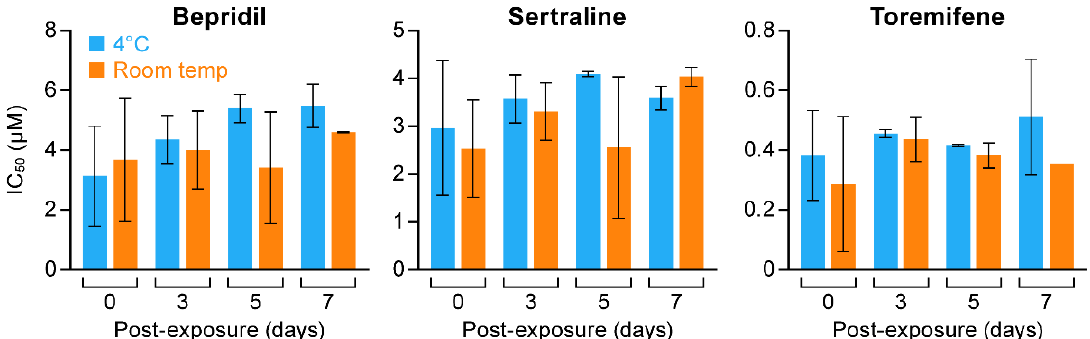
Figure 3. Activity of bepridil, sertraline and toremifene in V8 against EBOV/Mak over seven days. Drug stocks were prepared on d0 in V8 as for Figure 2, stored at 4 °C (blue bars) or RT (orange bars), and then tested in 8 point dose reScheme 0. d5, and d7 using 2-fold serial dilutions in V8. Huh7 cells were pretreated with the indicated drugs and infected with EBOV/Mak (moi 0.21). Two experiments were conducted; for each, dose response curves were run on duplicate plates with 3 replicates of each dose on each plate, and analyzed to obtain IC 50 s as described in the Methods section. Data from the triplicate technical replicates on each plate were averaged. The data shown are the averages of the average IC 50 s +/− sd from two to four plates. Data from plates with Z’ factor <0.2 were not included.